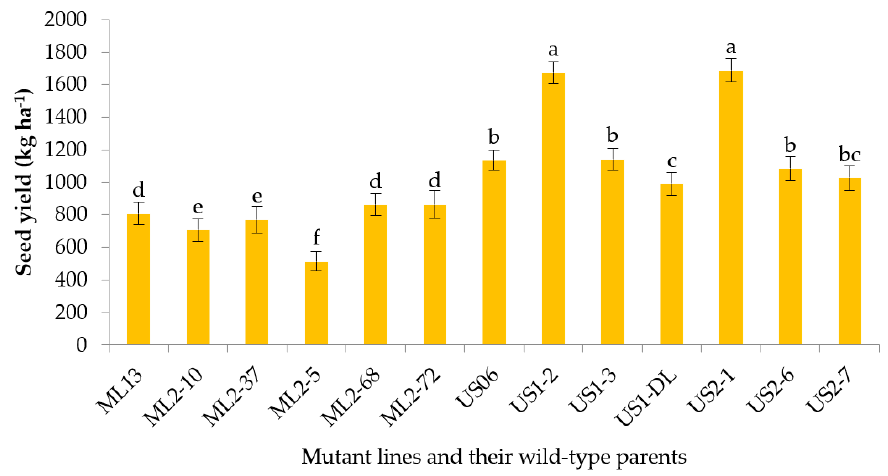
Figure 10. Average seed yield (kg · ha − 1 ) in 11 sesame mutant lines and their two wildtypes (US06 and ML13). The superscript letters represent the groups according to Duncan’s test.